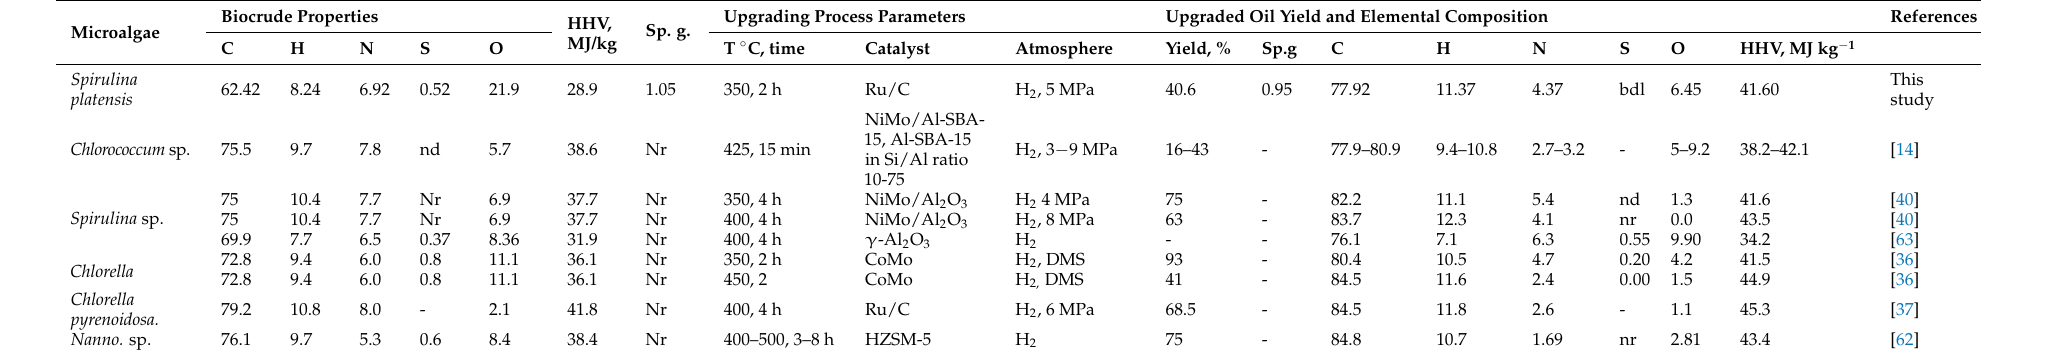
Table 5. Properties of upgraded products from HDO of algal biocrude using